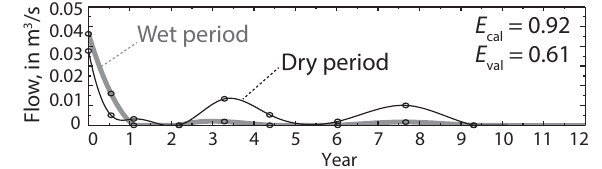
Figure 7. Example F9: nonparametric impulse-response functions for Barton Springs using a total of 16 control points.